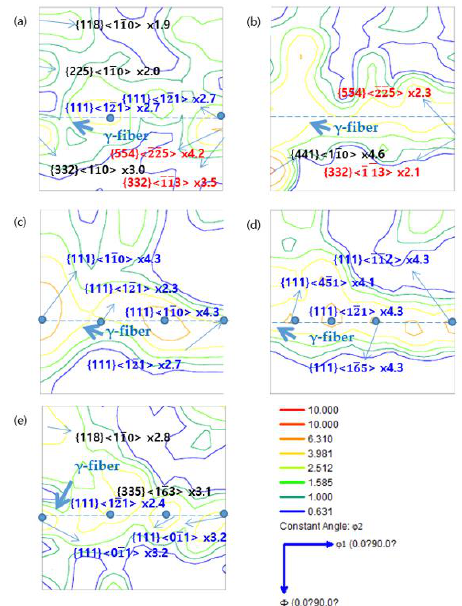
Figure 8. ϕ 2 = 45 ◦ section of the ODF in the alloy B steel specimens heat-treated under di ff erent Figure 8. φ 2 = 45° section of the ODF in the alloy B steel specimens heat-treated under different conditions: ( a ) as-received, ( b ) 800 °C, 6 min, ( c ) 1050 °C, 6 min, and 800 °C, 6 min, ( d ) 1050 °C, 30 conditions: ( a ) as-received, ( b ) 800 ◦ C, 6 min, ( c ) 1050 ◦ C, 6 min, and 800 ◦ C, 6 min, ( d ) 1050 ◦ C, 30 min, min, and 800 °C, 6 min, and ( e ) 1150 °C, 6 min, and 800 °C, 6 min. and 800 ◦ C, 6 min, and ( e ) 1150 ◦ C, 6 min, and 800 ◦ C, 6